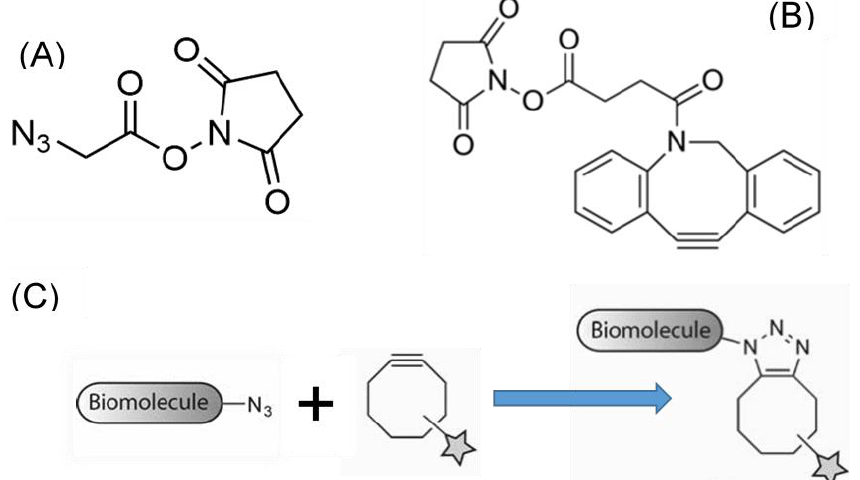
Figure 3. ( A ) Structural formula of the azidoacetic acid NHS ester (NHS-azide) molecule. ( B ) Struc- tural formula of the dibenzocyclooctyne-N-hydroxysuccinimidyl ester (NHS-alkyne), and ( C ) Scheme of the cycloaddition reaction between the azide and stressed alkyne groups.